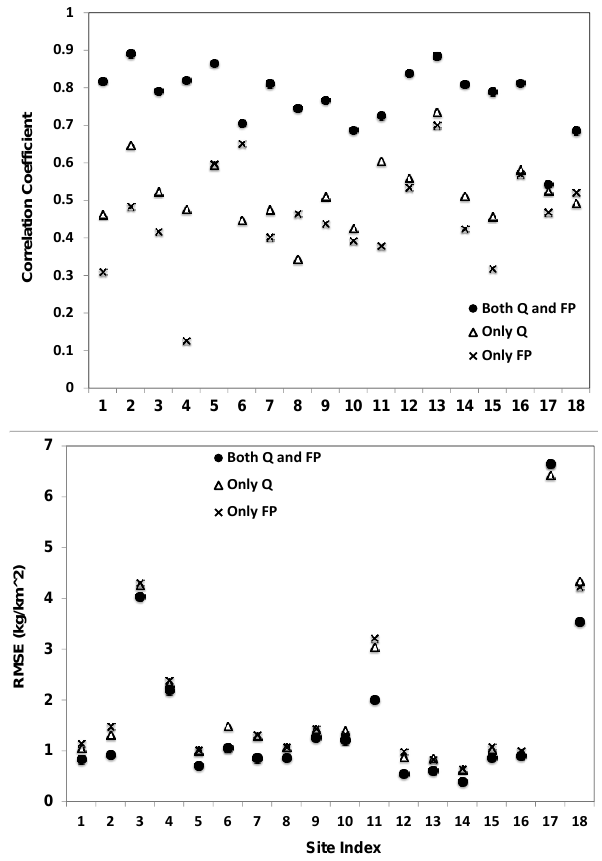
Figure 9: The role of different predictors, 3-day average daily streamflow prior to forecasting day (Q) and 1-day ahead precipitation forecasts (FP), in forecasting the observed TN loadings is expressed as (a) correlation coefficient and (b) RMSE between the observed TN and the forecasted TN loadings for the 18 selected sites.